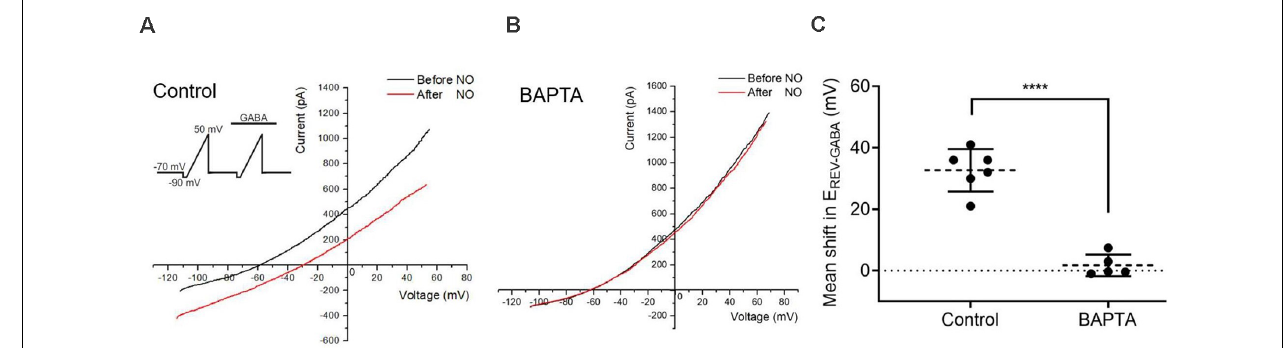
FIGURE 2 | Calcium elevations are required for the NO-dependent release of internal Cl − . (A,B) The current-voltage relationship for the GABA-gated current (20 µ M) before and after NO. Inset shows the voltage ramp protocol with GABA delivered during the second ramp. Under control conditions, E right. With the Ca 2+ chelator, BAPTA (50 µ M) in the recording pipette, NO fails to elicit the E REV-GABA shift. (C) The quantified mean shift in E REV-GABA ± SEM; control, n = 6; BAPTA, n = 5. **** P < 0.0001 (unpaired t